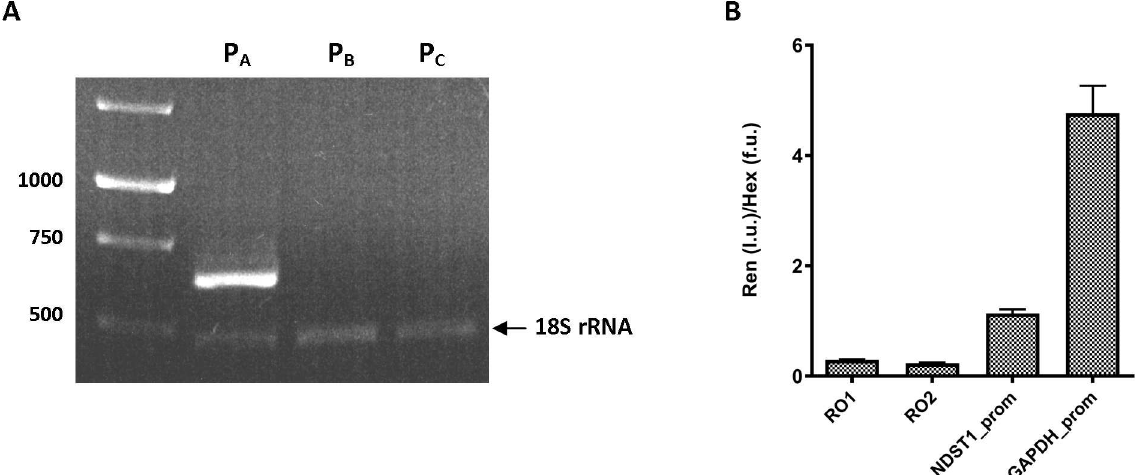
Fig 2. Confirmation of alternative NDST1 transcripts by RT-PCR and assessment of NDST1 promoter (P A region)— luciferase construct activity. (A) Reverse transcription PCR for alternative NDST1 transcripts. Complementary DNA reversely transcribed from total extracted RNA of normal human fibroblast was used in the PCR to identify expressionlevels of each of the possible NDST1 transcripts. Primers flanked the sequence of 5’ UTR (exon 1) and codingregion (exon 2) were expectedto produce 637, 700, 688 bp PCR fragments for NDST1 mRNA transcribedfrom P A , P B and P C respectively. PCRs with these primers amplifiedonly NDST1 mRNA transcribedfrom P A region. 18S rRNA was used as an internalcontrol. (B) Activity of NDST1 promoter—renilla luciferase reporter construct. Renilla luciferase expression vector containing either: i) two random DNA sequences, RO1 and RO2 (negative controls); ii) NDST1 promoter (P A region); or iii) GAPD H promoter (positive control) were transiently transfected into HeLa cells. DNA fragments activity is shown as a normalizedvalue of luminescence (produced by renilla luciferase) to fluorescence (produced by Hex). Experiments were conductedin triplicates. Ren—renilla luciferase activity, l. u.—luminescence units, f.u.—fluorescence